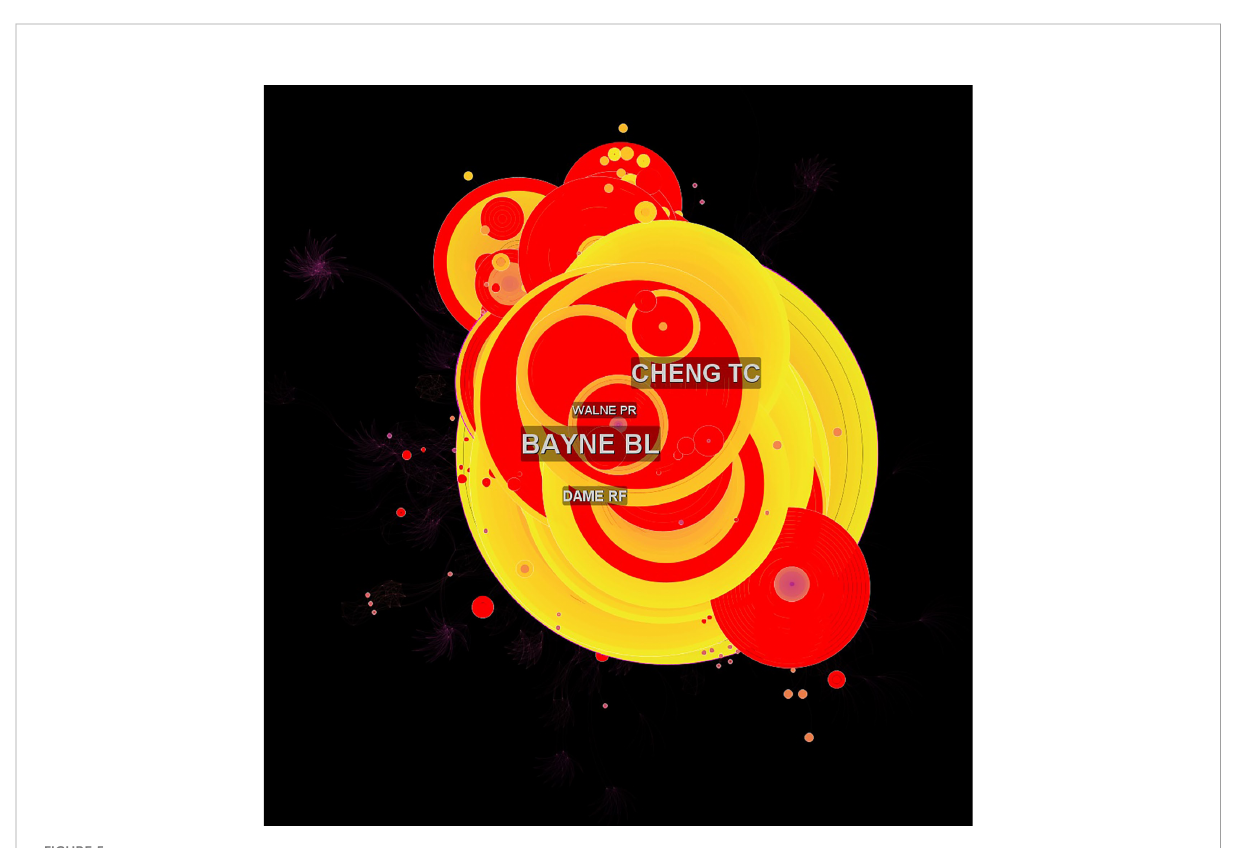
FIGURE 5 Author co-citation